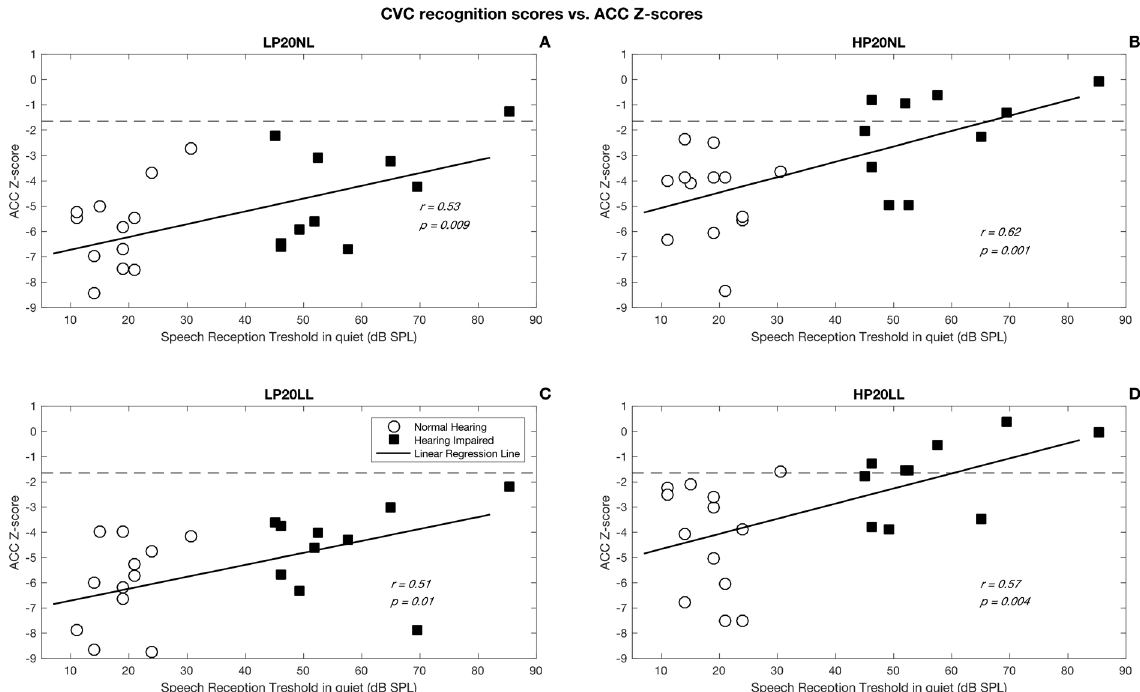
Figure 3. Correlation between speech perception in quiet and ACC z-scores for 4 stimuli. Panel ( A ) shows results for the low-pass filtered stimuli presented at normal conversational level (LP20NL), panel ( B ) shows results for the high-pass filtered stimuli presented at normal conversational level (HP20NL), panel ( C ) shows results for the low-pass filtered stimuli presented at low level (LP20LL), and panel ( D ) shows results for the high-pass filtered stimuli presented at low level